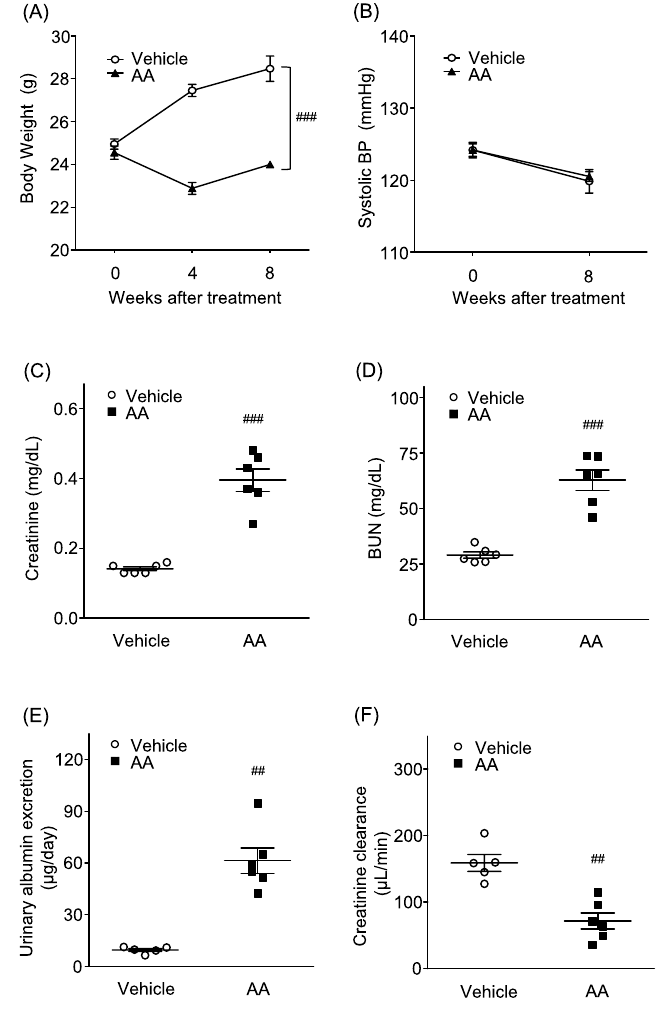
Figure 3. Body weight, blood pressure, and renal functions in aristolochic acid (AA)-induced CKD model mice. ( A ) Body weight changes in vehicle and AA groups. ( B ) Systolic blood pressure in vehicle and AA groups at 0, 4, or 8 weeks after treatment. ( C ) Plasma creatinine level, ( D ) BUN level, ( E ) urinary albumin excretion, and ( F ) creatinine clearance were measured at 8 weeks after treatment in vehicle and AA groups. Values are expressed as mean ± standard error of the mean (5–6 mice per group). P values, versus vehicle: # P < 0.05; ## P < 0.01; ### P < 0.001. CKD, chronic kidney disease; BP, blood pressure; BUN, blood urea